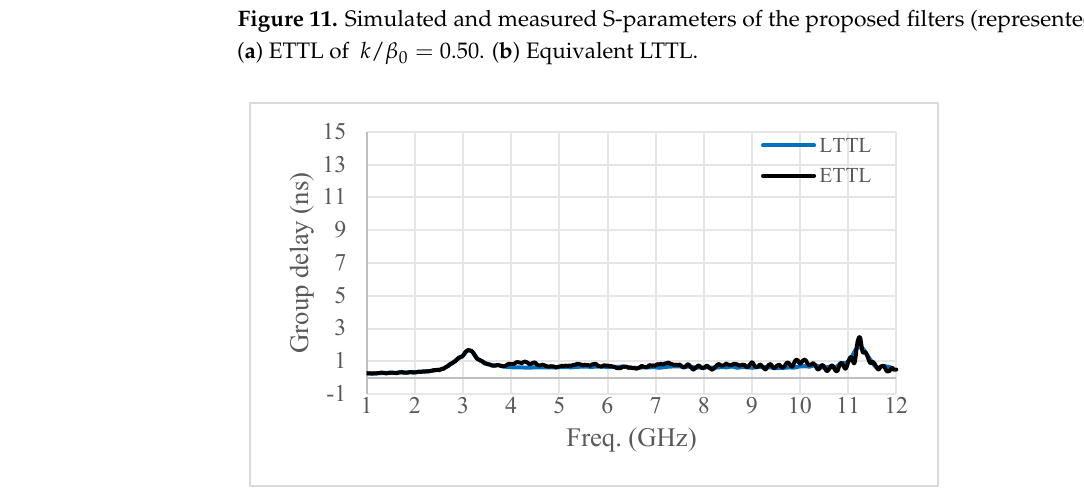
Figure 12. Measured group delay of the designed UWB ETTL filter of k / β 0 = 0.50.